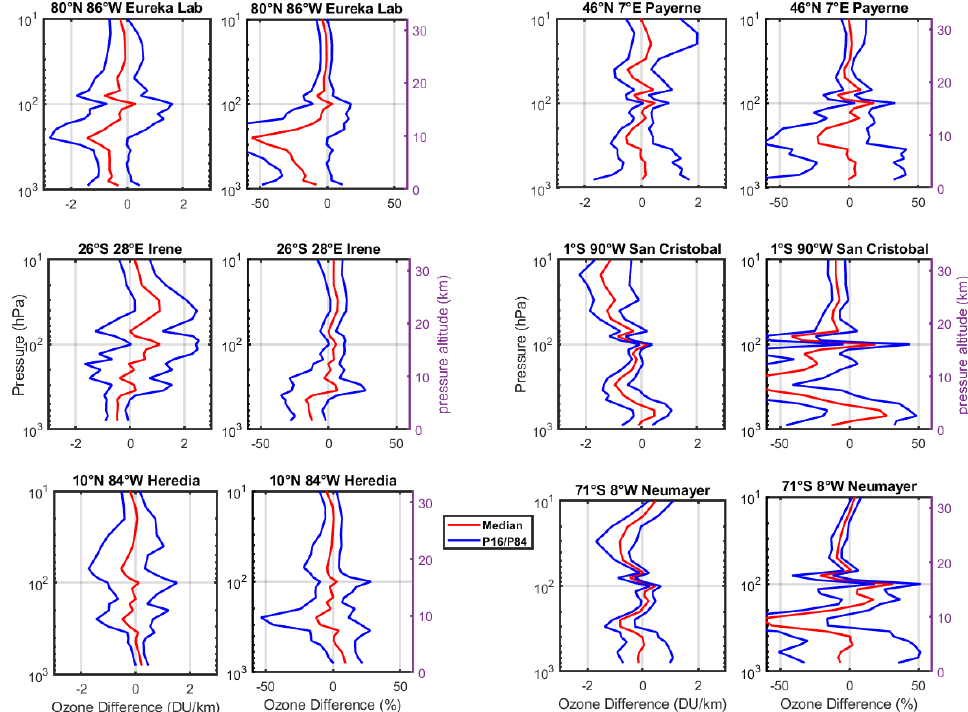
Figure 14. The statistical parameters of differences between ozonesonde and collocated interpolated limb profiles. The red lines show the median of absolute (left panels) and relative (right panels) differences, while blue lines show the 16th and 84th percentiles.